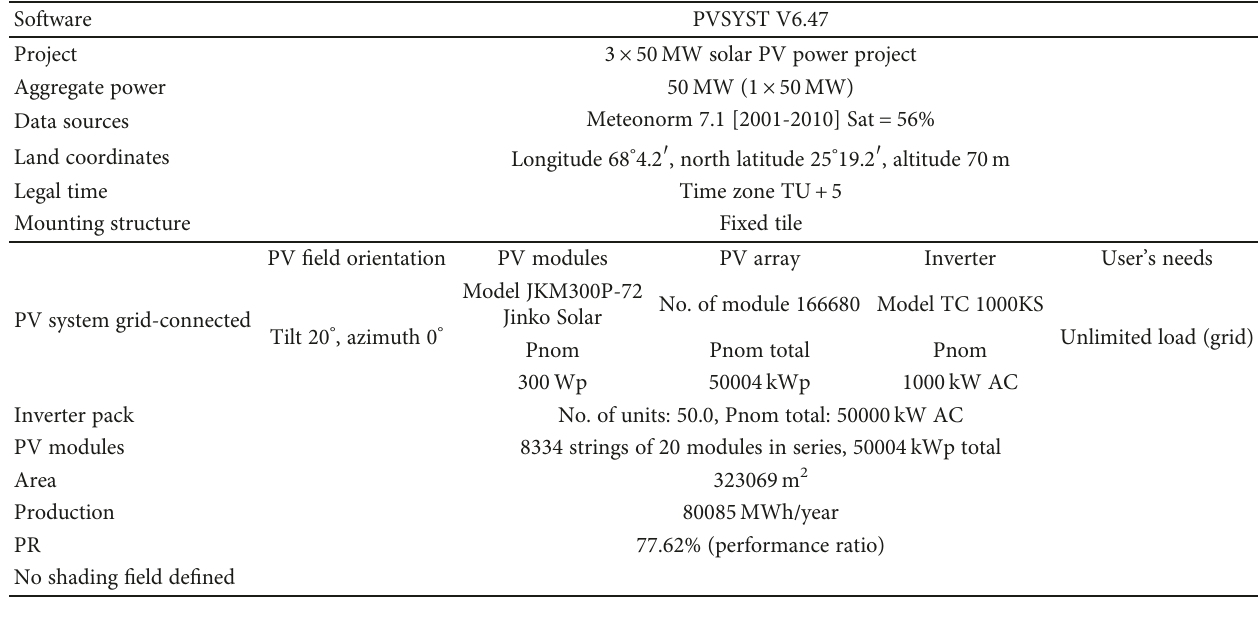
Table 8: Energy assessment results through